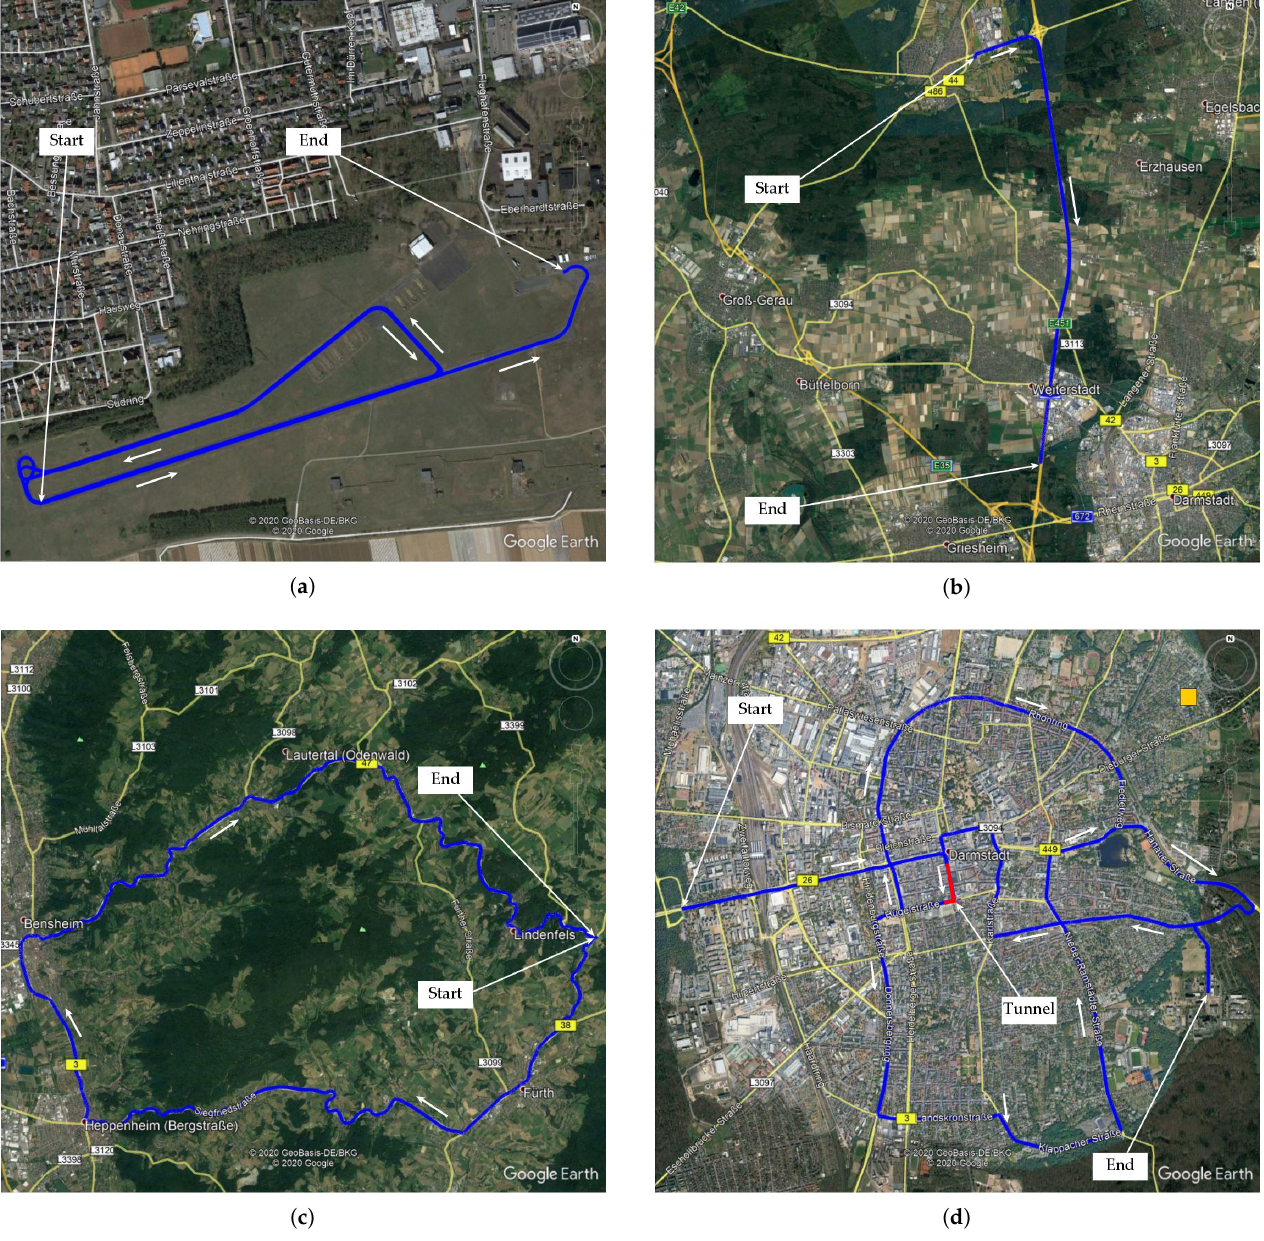
Figure 5. Driven trajectory in the four selected experiments: ( a ) TU Darmstadt airfield Griesheim, Germany, ( b ) Highway A5 near Darmstadt, Germany, ( c ) Odenwald near Heppenheim, Germany, ( d ) Darmstadt, Germany (Screenshots taken from Google Earth Pro, map credits given on the